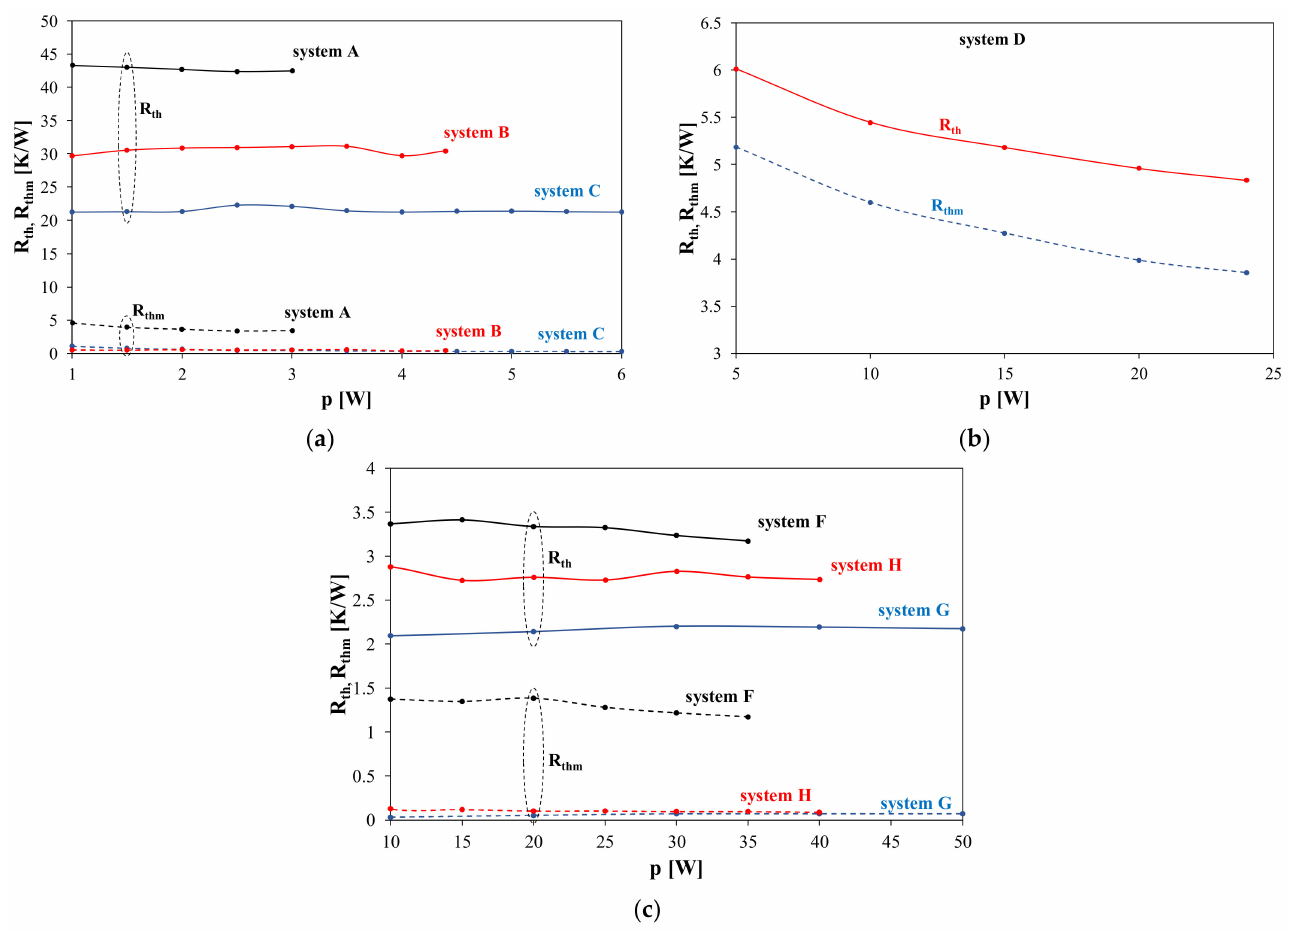
Figure 16. Dependences of R th and R thm of the investigated MOSFETs with cooling systems ( a ) A–C,